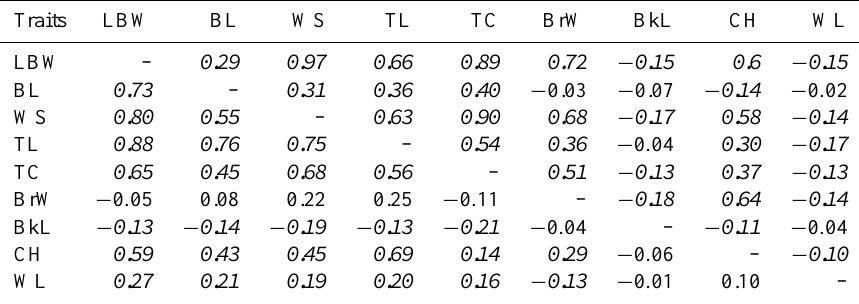
Table 5. Pearson correlations between traits recorded for males (below diagonal divide, n = 322) and females (above diagonal divide, n = 456). Correlations that are significantly different from zero are written in